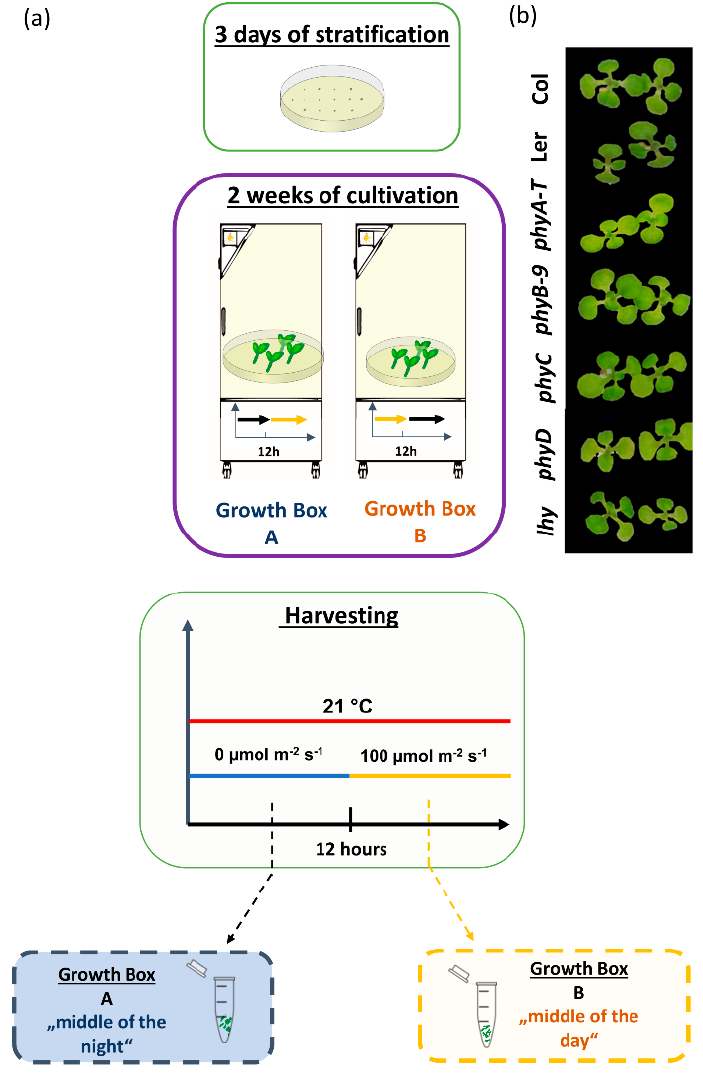
Figure 1. The experimental design ( a ) and representative images of two-week-old plantlets ( b ). 2.2. Plant Analysis Did Not Show Striking Differences in Total Proteome Composition The proteome analysis of Arabidopsis plantlets provided the identification and quan- titation of 3795 and 2587 proteins, respectively. The ANOVA analysis found more